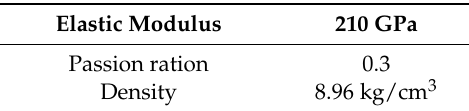
Table 2. The attributes of nickel.